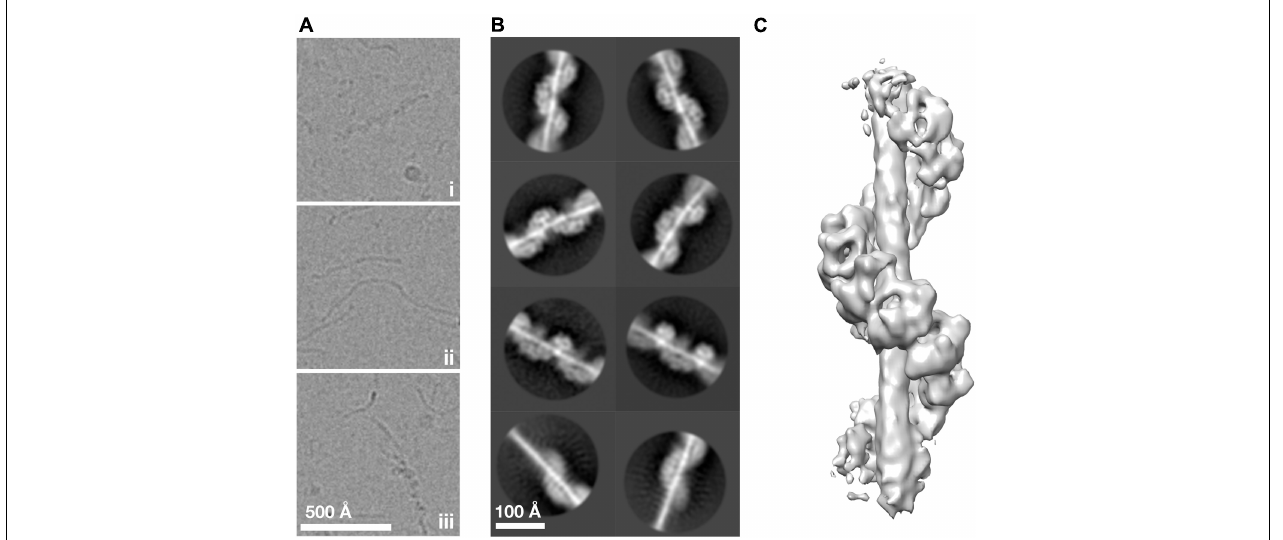
FIGURE 2 | ArlG forms a helical filament. (A) Representative examples of purified P. furiosus sArlG demonstrating (i) helical filaments corresponding to previous results. Micrographs also featured (ii) thinner filamentous structures and (iii) helical filaments that transitioned to thinner filaments, mid-filament. (B) Representative 2-D classes on helical filaments; the bottom row shows 2-D classes of helical-to-thinner transitions, confirming their relation. (C) Isosurface of the final 3-D reconstruction of sArlG helical filament reveals an open helix of repeating densities around a central